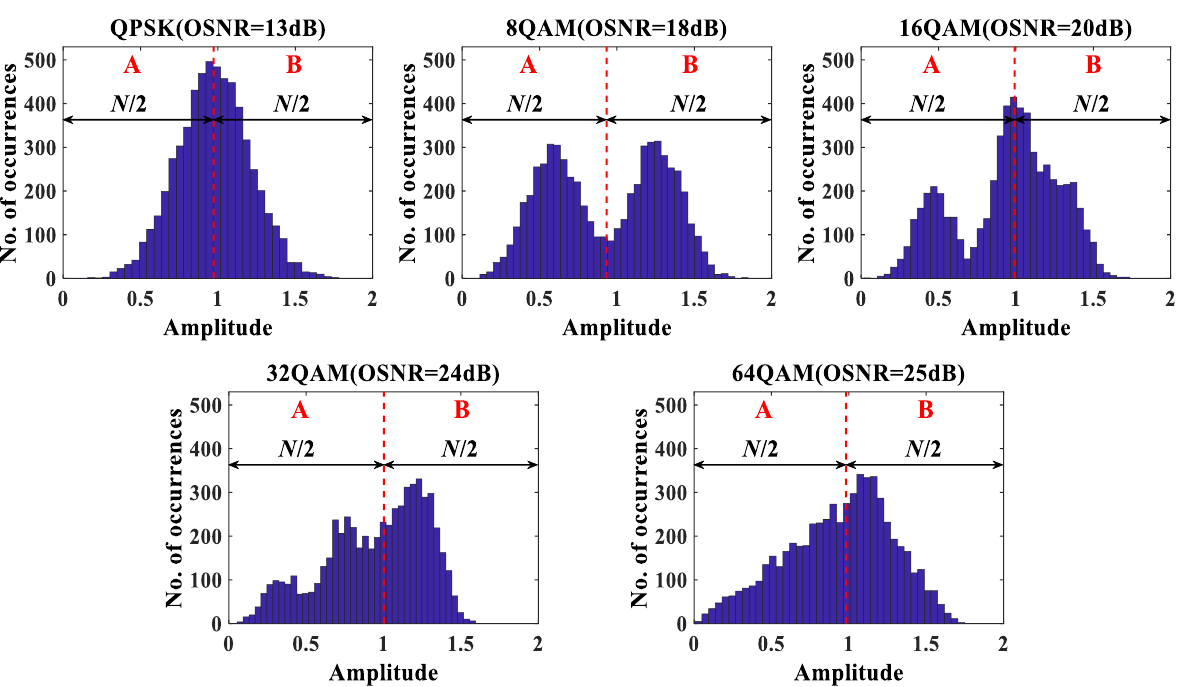
Figure 3. The first partition operation for the amplitude histograms of QPSK, 8QAM, 16QAM, 32QAM and 64QAM. The amplitude histograms are divided into two parts based on the number of symbols, which is N /2 in both part A and part B.